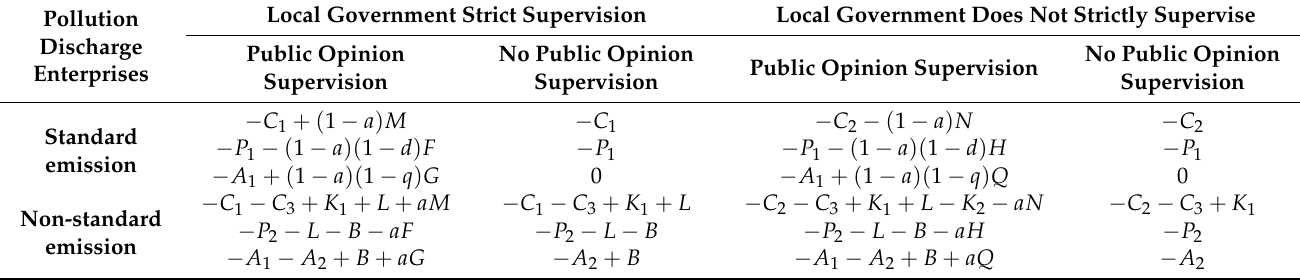
Table 1. The payoff